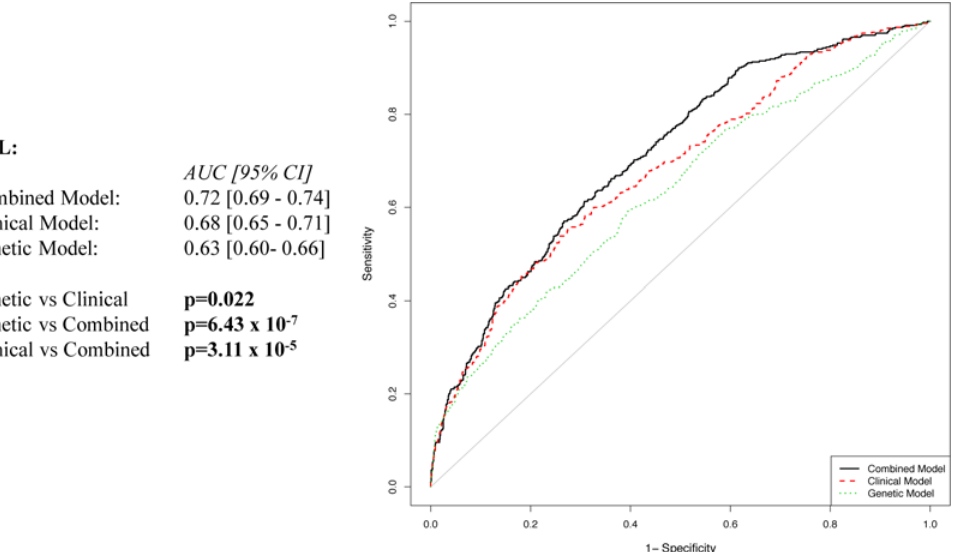
Fig 3. Receiver operating characteristic curve for association with venous thromboembolism in the whole population. Variables included in the models: Genetic = KIV-2 repeats; Clinical = age, sex, hypertension, smoking habit, dyslipidemia, diabetes, BMI, hyperhomocysteinemia, and oral contraceptives/HRT; Combined = Genetic + Clinical